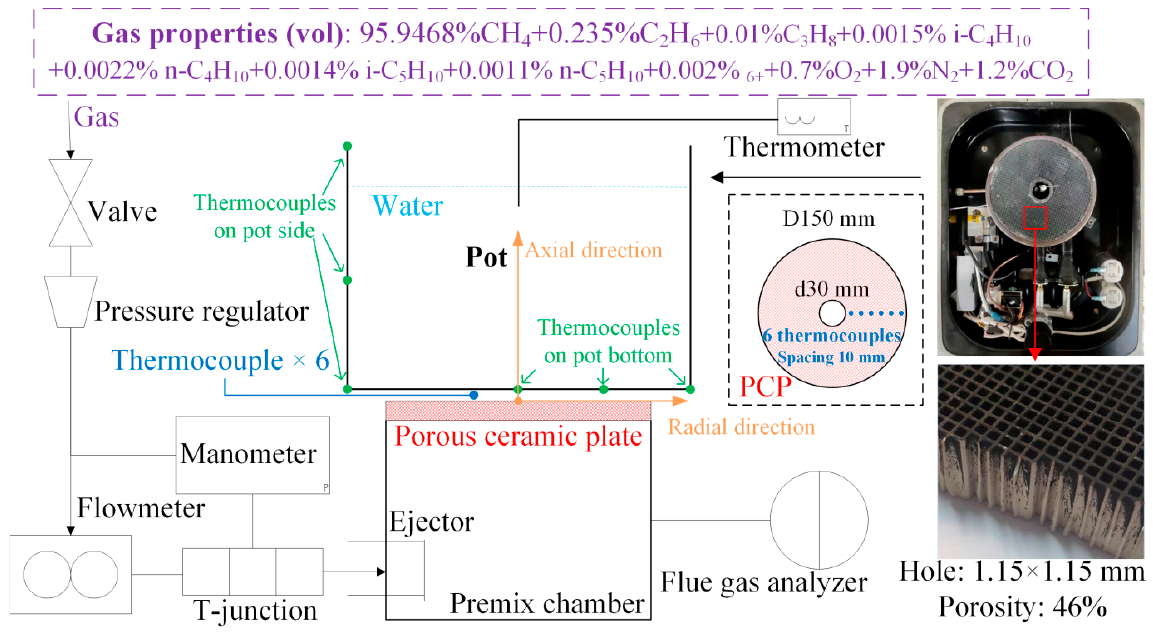
Figure 2. Experimental system.